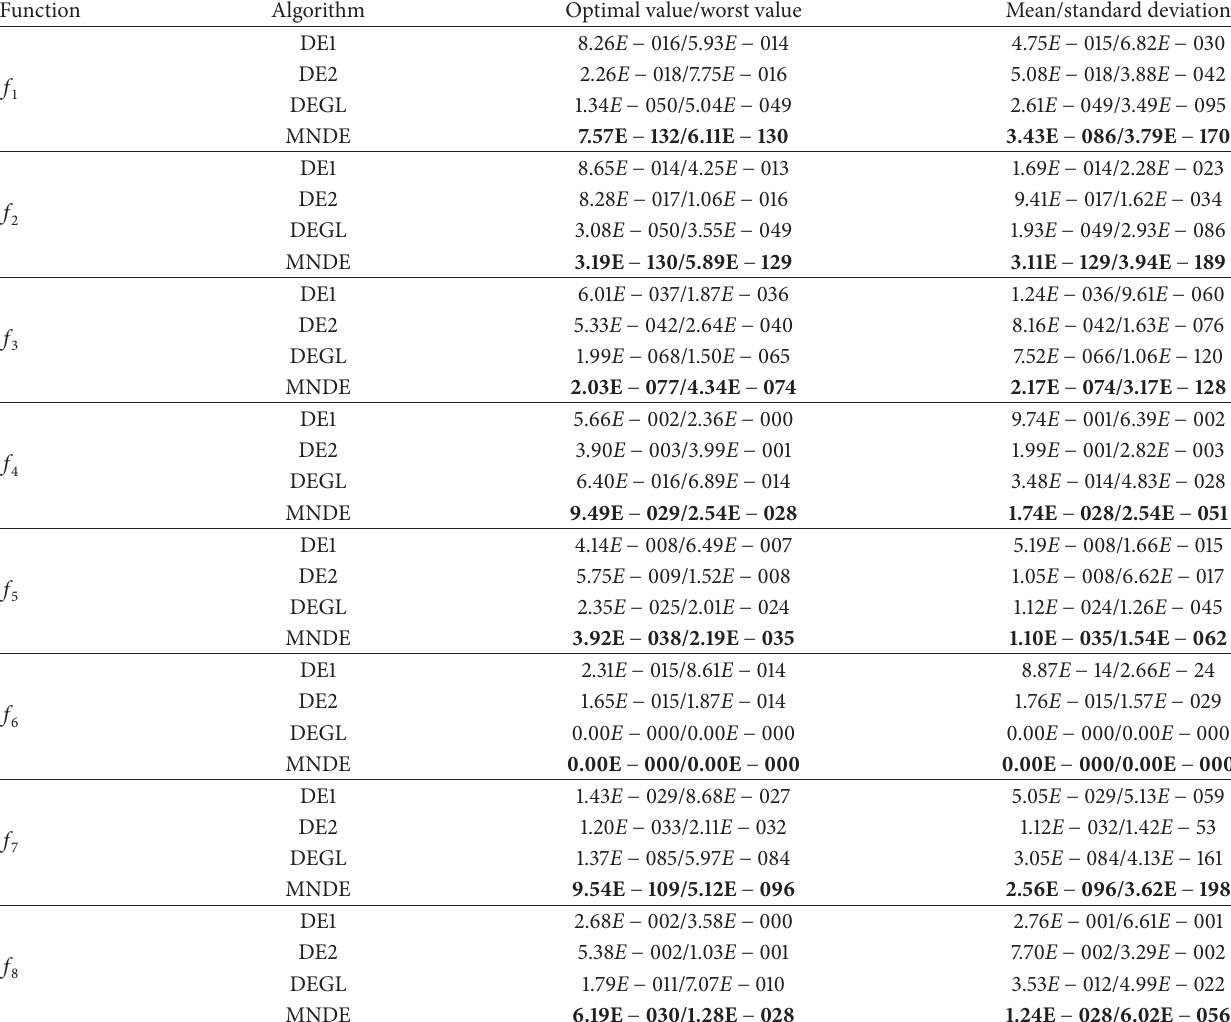
Table 2: The optimal solution, the worst solution, the mean, and the standard deviation tested on various benchmark